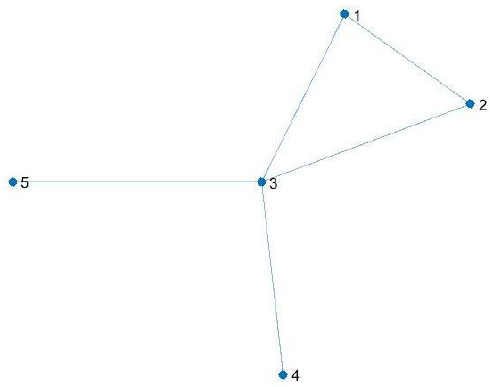
Figure 4. The graph G ( δ ) with δ = 0.71. Vertex number refers to the associated